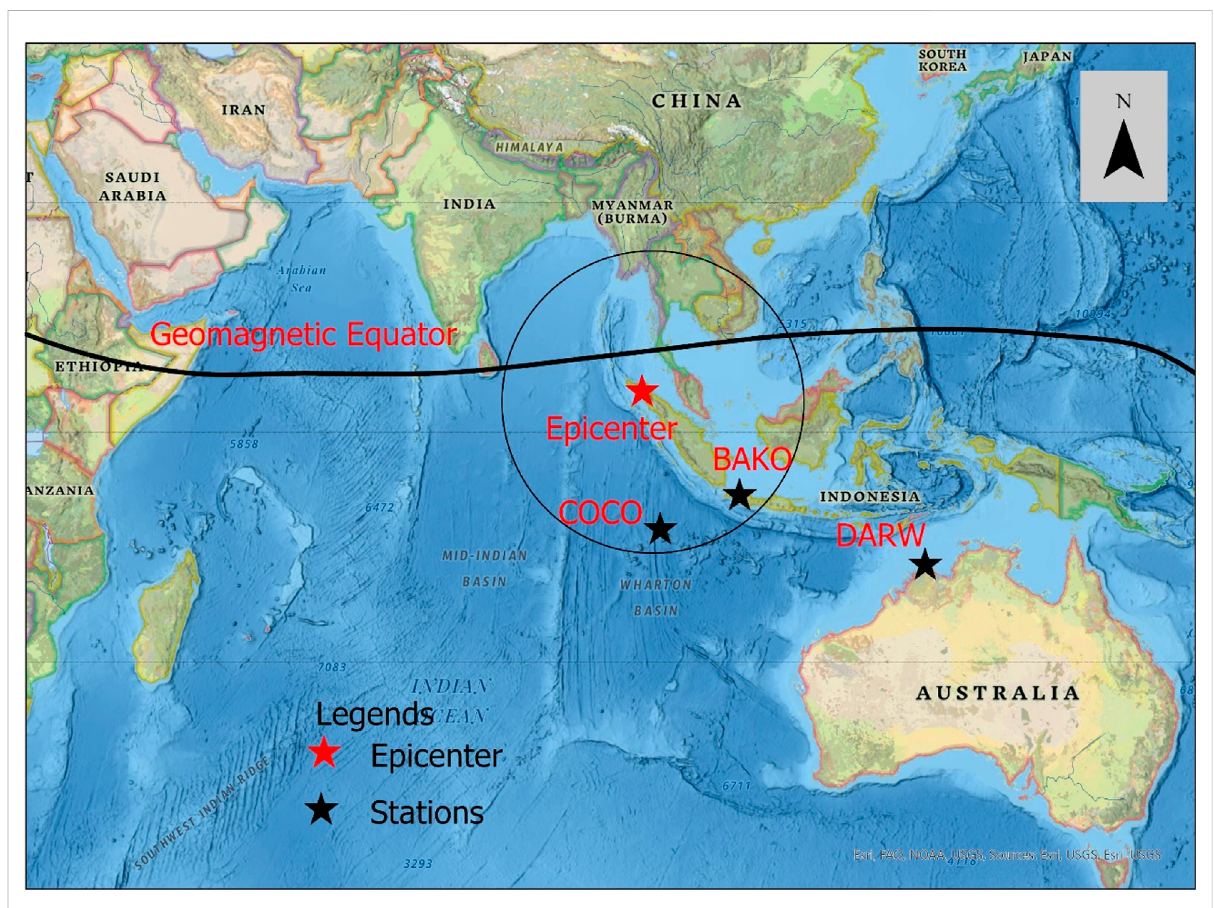
FIGURE 1 GeographicallocationoftheSumatraEQthatoccurredon06December2016andtheGPSstationsaroundtheepicenter.Thestationnameand geomagnetic equator are shown at their respective